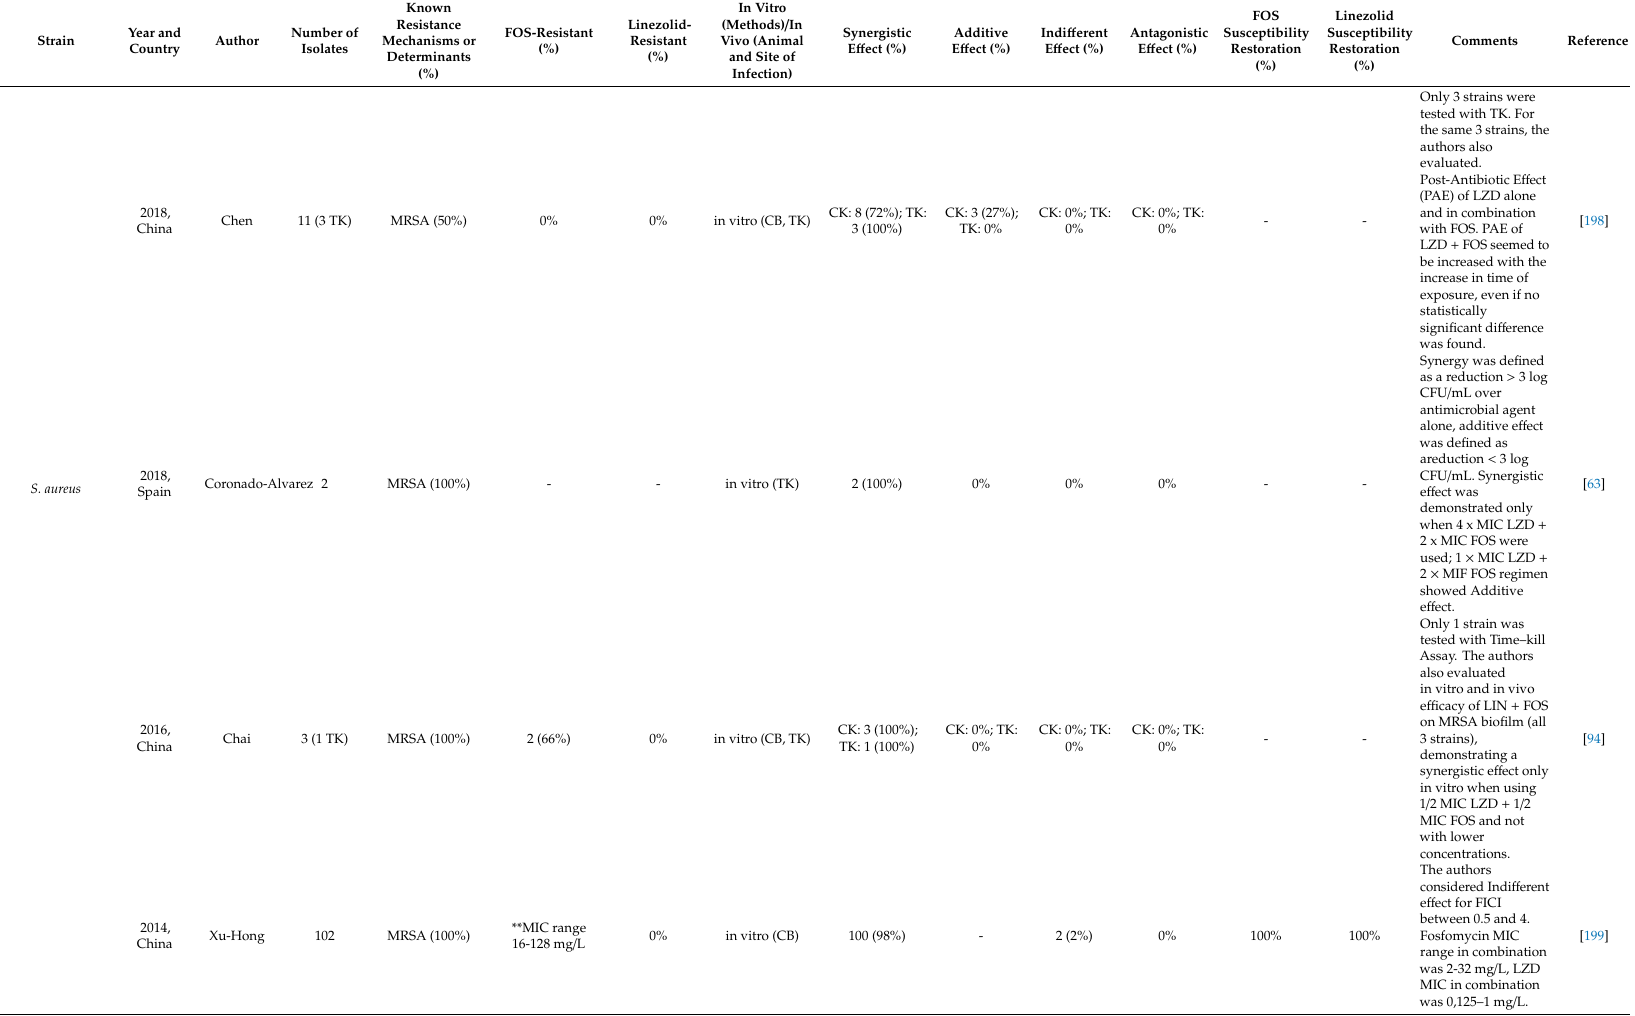
Table 13. Studies on combination between fosfomycin and linezolid. CB: checkerboard assay; TK: time–kill assay; ET: